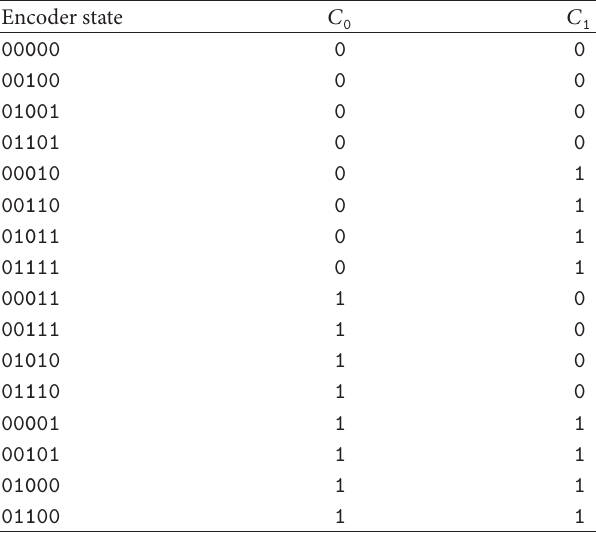
Table 3: Step 1 output is rearranged and then decomposed into RT and CT.